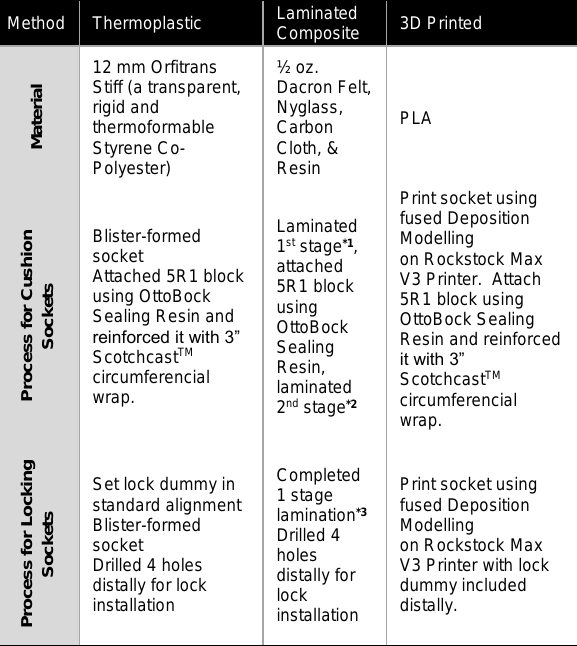
TABLE 2. The offset values for the top and bottom load application points for all conditions and levels. The forward direction is